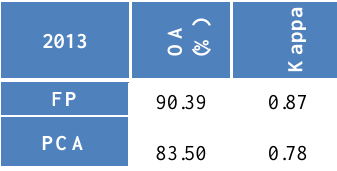
Table 1: accuracy assessment of 2013